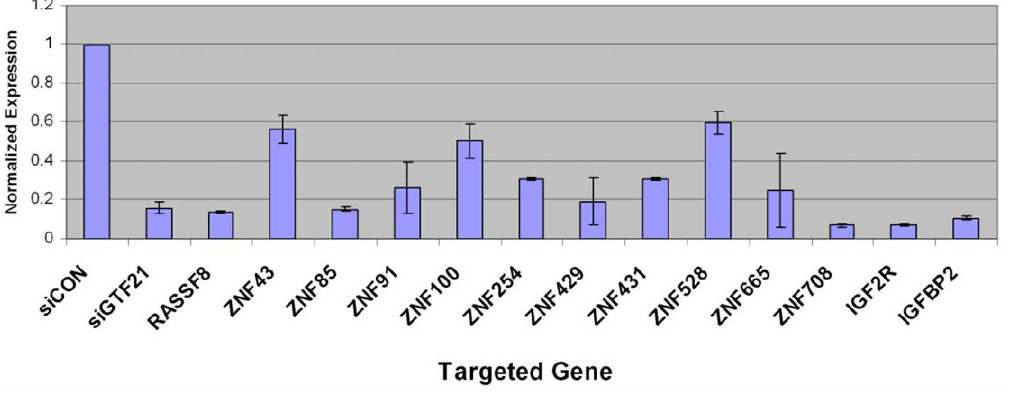
Figure 2. Validation of target gene knockdown by quantitative RT-PCR. RNA expression of indicated target genes in GIST T1 cells after knockdown with corresponding siRNA. Expression levels were normalized to HPRT. Results are of three independent experiments.